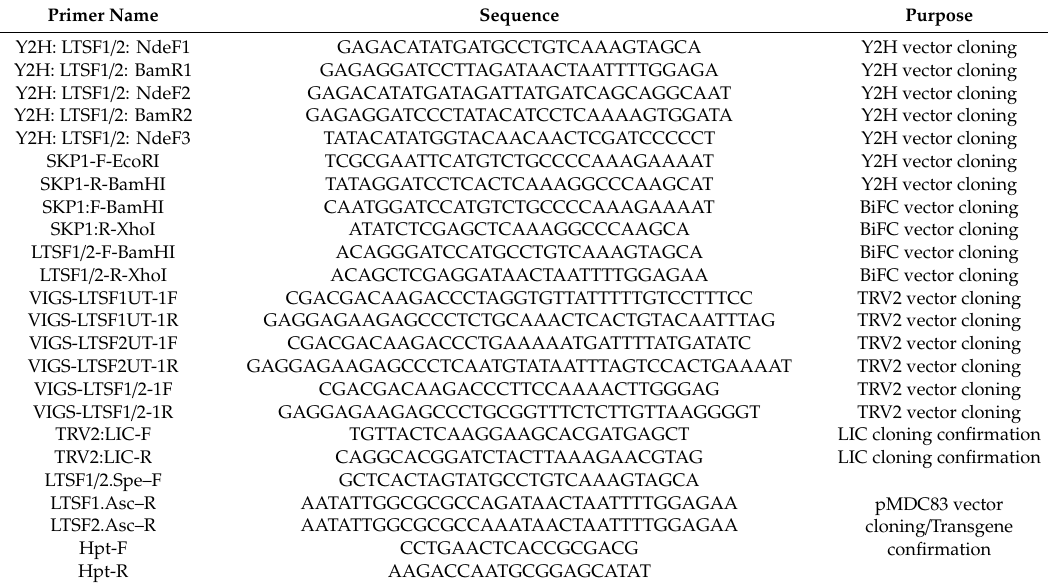
Table 1. Cloning primers used in this